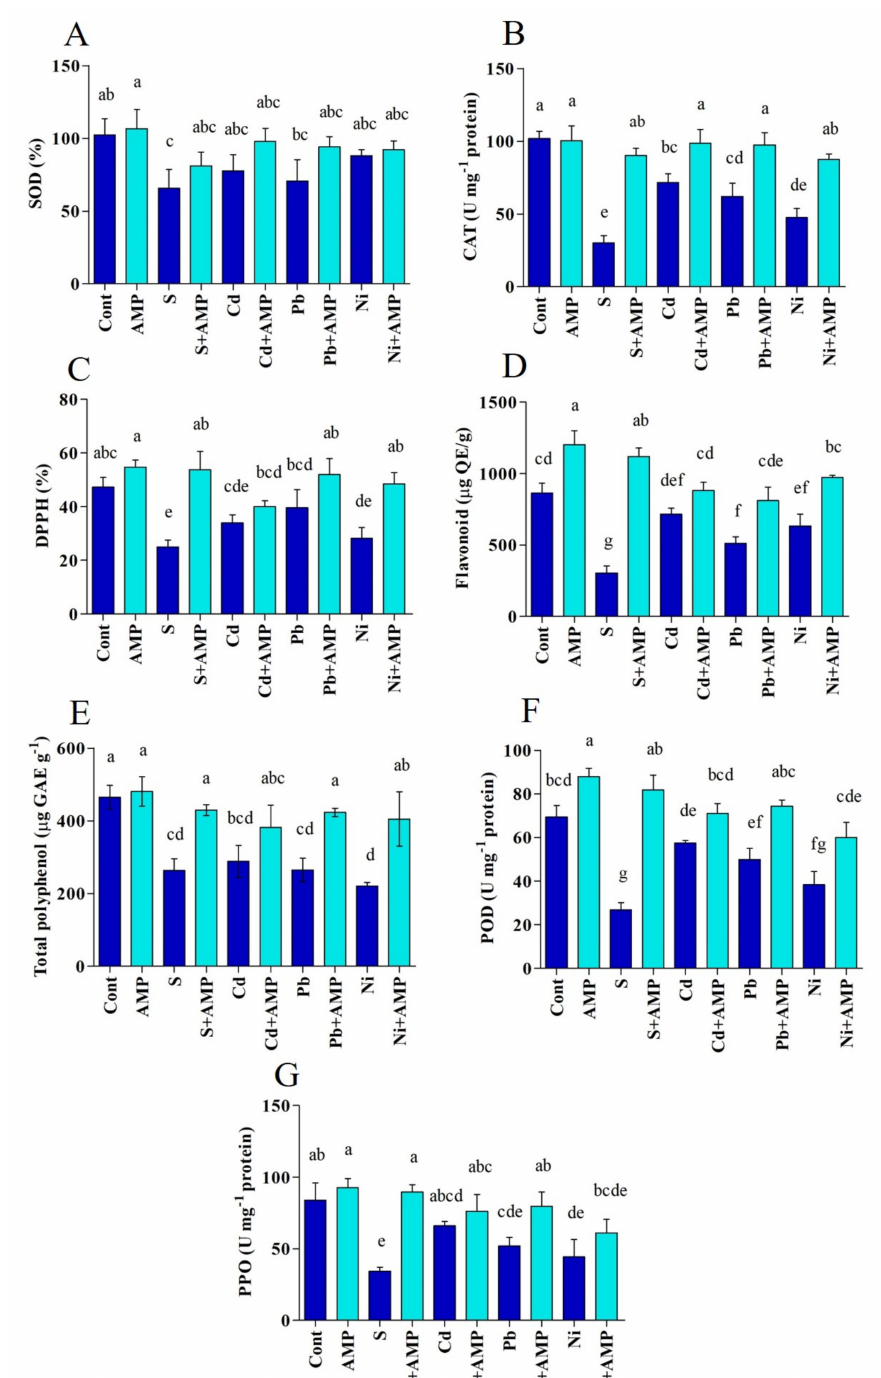
Figure 5. Antioxidant content (SOD), ( A ); CAT, ( B ); DPPH, ( C) ; flavonoids, ( D ); total polyphenol, ( E ); POD, ( F ); and PPO, ( G ) of soybean leaves grown under normal and stress conditions and treated with ampelopsin for 12 days (12DAT). Treatments: Cont (control), AMP (1 µ M ampelopsin), S (1.5% sodium chloride), AMP (1 µ M ampelopsin) + S (1.5% sodium chloride), Cd (3 mM cadmium), 1 µ M AMP (ampelopsin) + Cd (3 mM cadmium), Pb (3 mM lead), AMP (1 µ M ampelopsin) + Pb (3 mM lead), Ni (3 mM nickel), and AMP (1 µ M ampelopsin) + Ni (3 mM nickel). Values show the means ± SE ( n = 5) and significant differences at p < 0.05 (Tukey test). Bars with different lowercase letters are significantly different from each